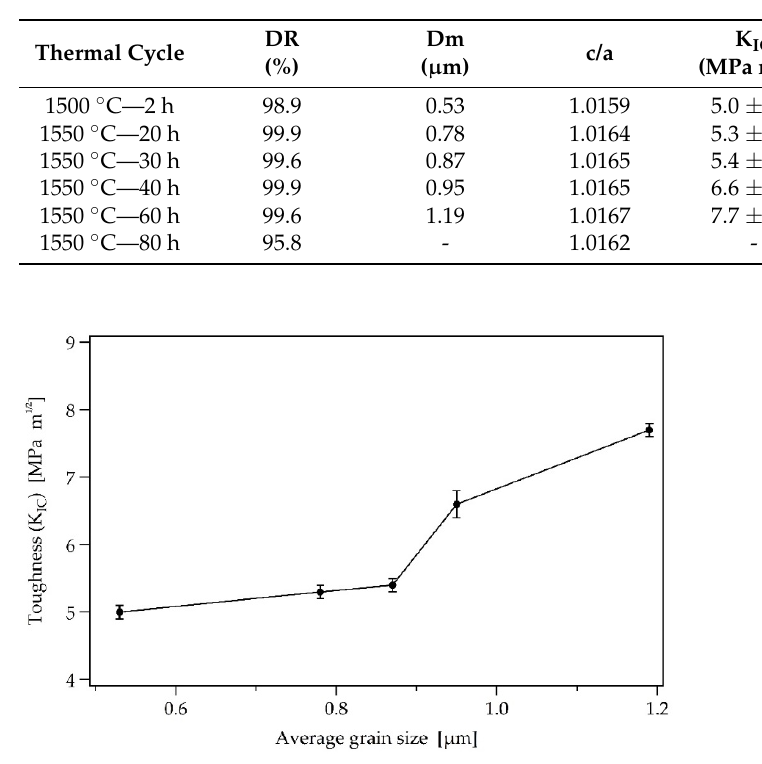
Figure 2. Fracture toughness vs. average grain size of the different sintered zirconia-based materials. The sample sintered at 1550 ◦ C for 80 h was characterized by the lowest sintered density due to the formation of the monoclinic phase, and it showed many cracks. In